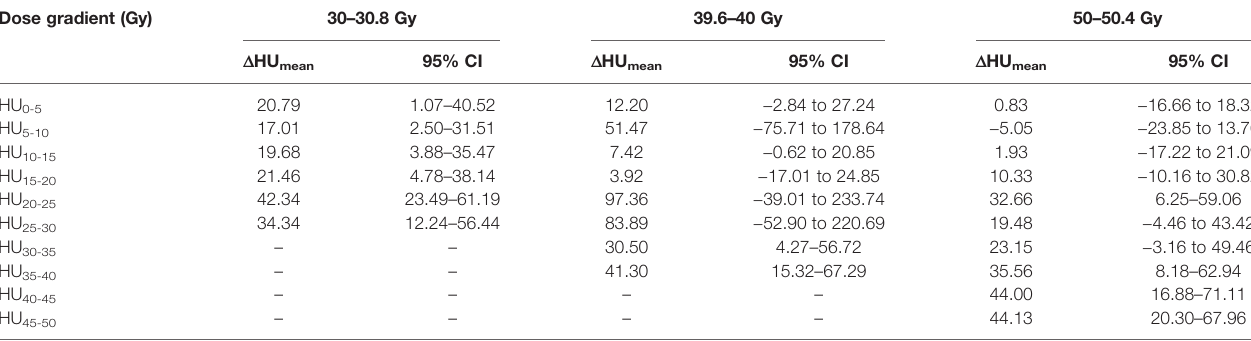
TABLE 3 | D HU in different dose gradients of patients in different re-planning groups. Dose gradient (Gy)